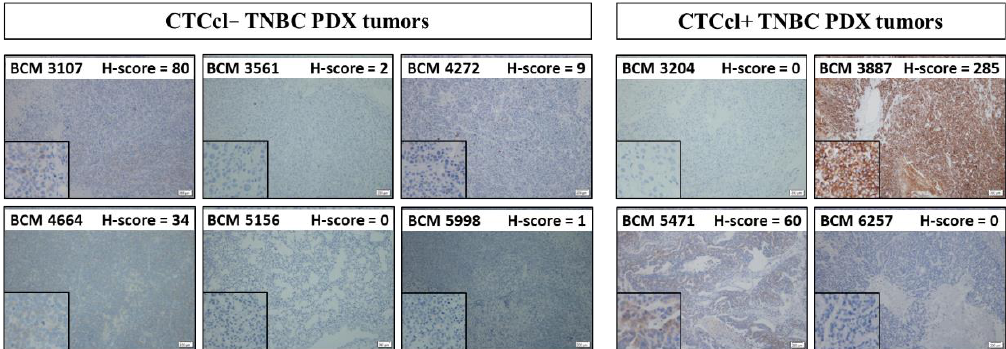
Figure 2. IHC analysis of B-cell lymphoma 2 (Bcl2) expression with H-score in CTCcl − vs. CTCcl + triple-negative breast cancer (TNBC) PDX tumors. Primary tumor tissues were sectioned and stained individually with an anti-Bcl2 antibody after antigen retrieval. Sections were exposed with metal enhanced 3,3 (cid:48) -Diaminobenzidine (DAB) substrate and counter-stained with hematoxylin. Histoscore was assigned based on staining intensity (0 (absent), 1 + (weak), 2 + (moderate), or 3 + (strong)) and the percentage of cells